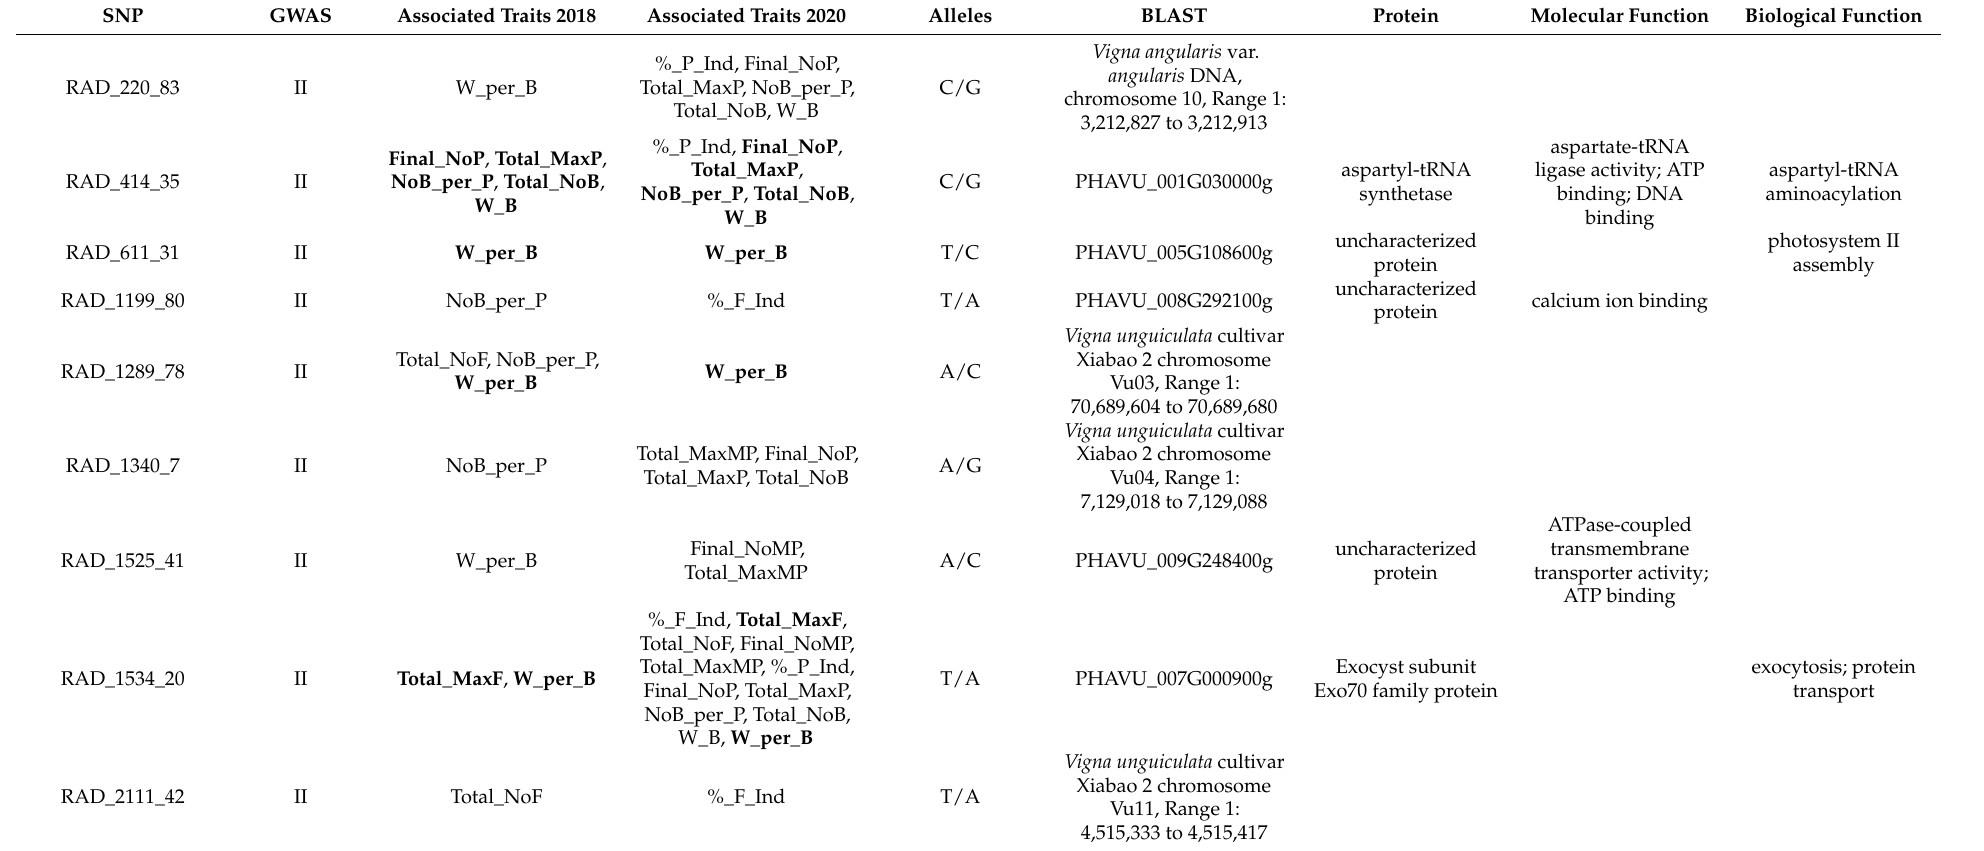
Table 2. Details of the final 18 SNPs associated to heat stress either from GWAS I or GWAS II. The associated traits are depicted for both years, 2018 and 2019, whereby traits that were associated in both years are highlighted in bold. For each SNP the two possible alleles are given, whereby the favorable allele (FA) is mentioned first. Further, each SNP is characterized by the best BLAST hit, by the protein that is encoded by the sequence, and finally by the molecular and biological function annotation by Uniprot. The explanation of the abbreviation of each trait is given in Table 1. NA : Not applicable. GWAS